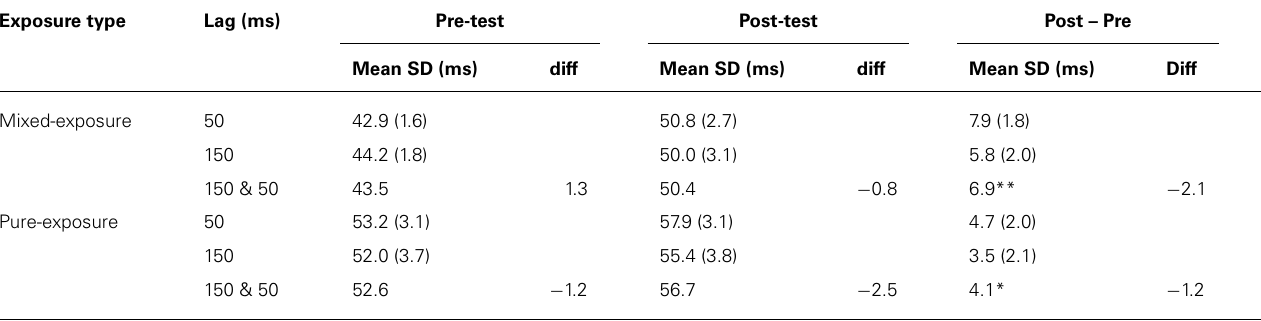
Table 4 | Mean standard deviation of